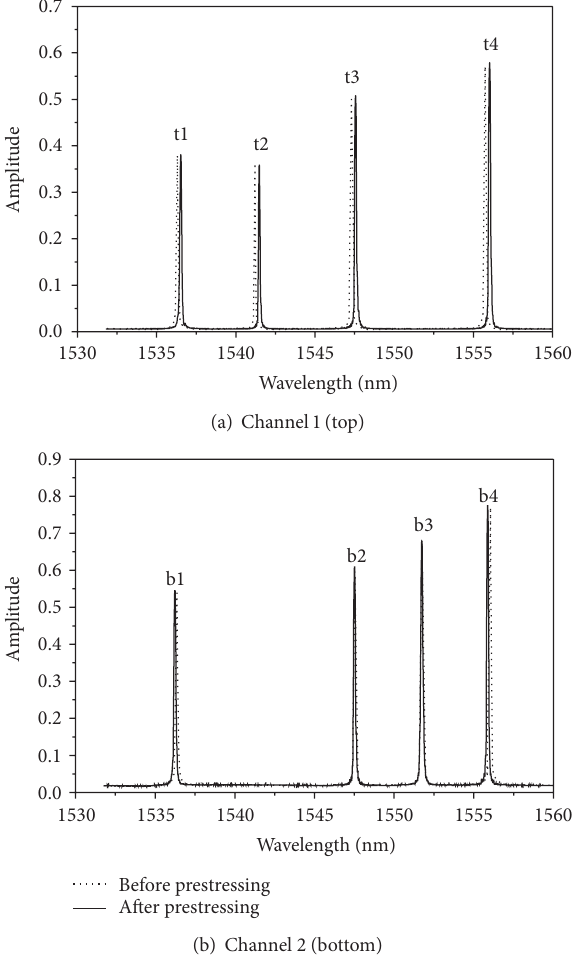
Figure 6: Wavelength shift induced by